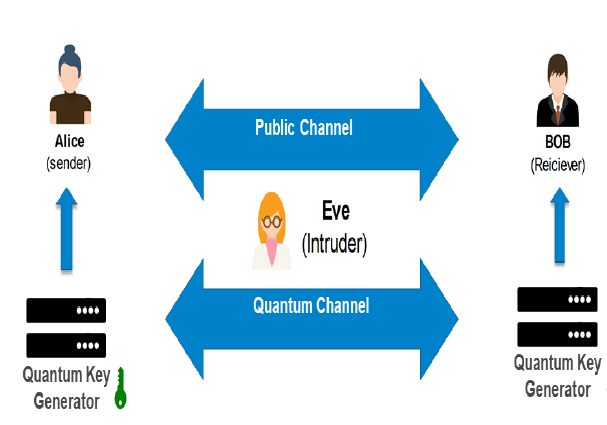
Figure 1. Quantum Key Distribution